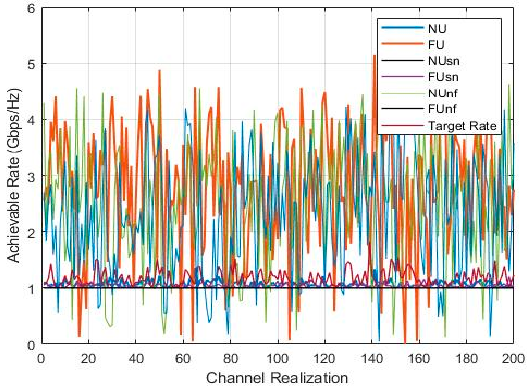
Figure 12. Instantaneous rate vs. channel realization.